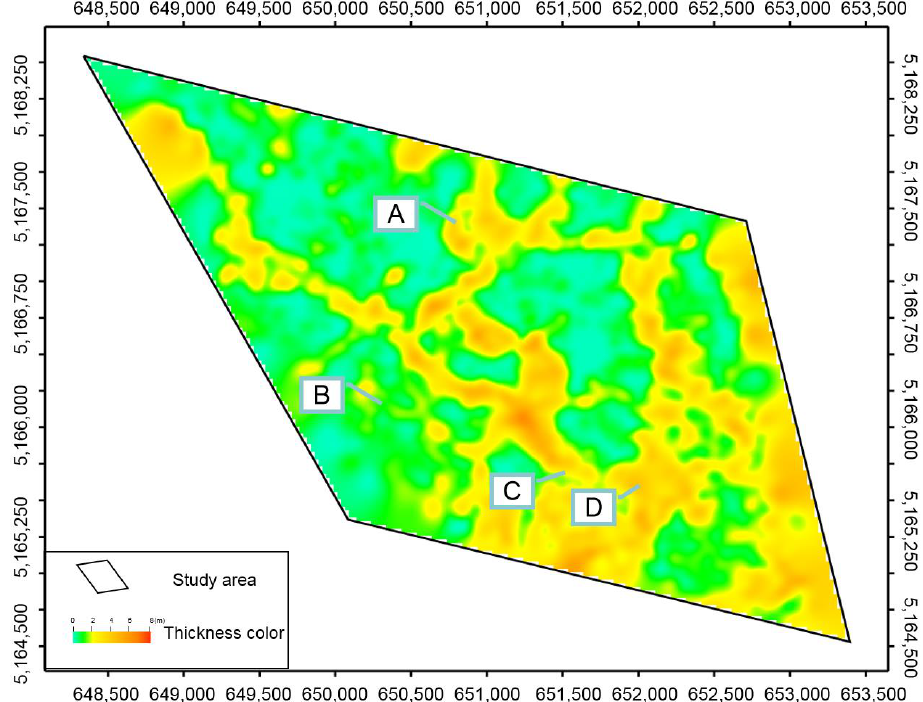
Figure 7. Sandstone thickness prediction map of G I2. A, B ,C and D are four different typical thickness variation locations of sandstone, corresponding to amplitude variation locations.